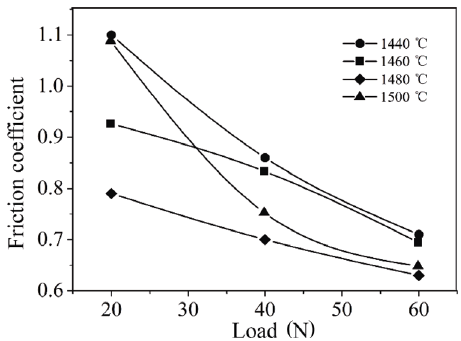
Fig. 12 Friction coefficient–pressure curve of the co-continuous composites. Table 5 Wear rate of co-continuous composites Temperature of sintering ( ℃